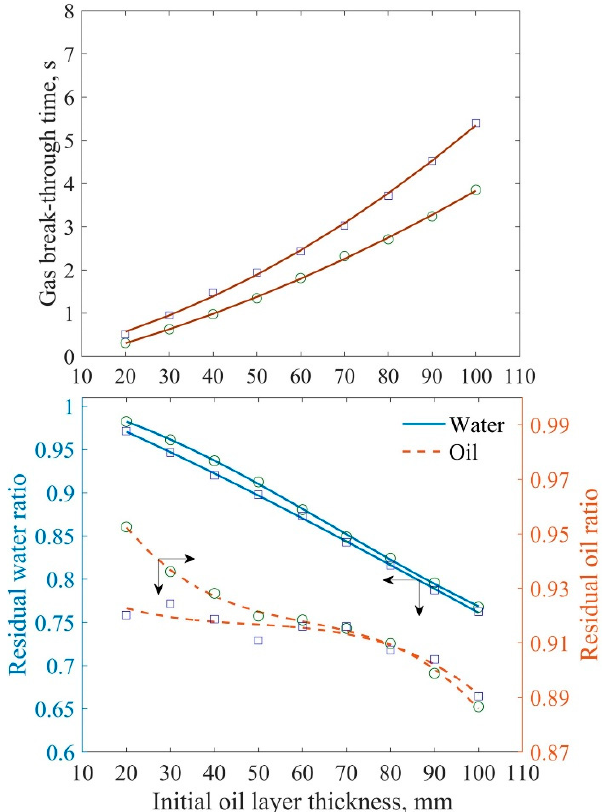
Figure 9. Upper panel: Effect of initial oil layer thickness on gas breakthrough time at different oil viscosities. Lower panel: Effect of initial oil layer thickness on residual ratios of both liquids at different oil viscosities. Initial l–l interface level: 10 mm, pressure difference: 0.3 bar, oil viscosity: 0.131 Pa·s (circles), 0.254 Pa·s (squares).